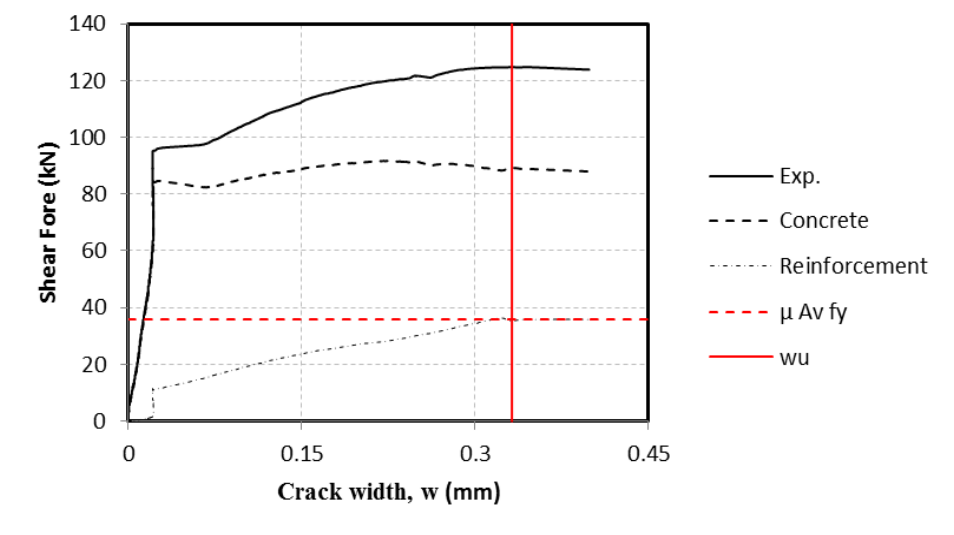
Figure 11. Experimental and theoretical shear strengths of SCR-A